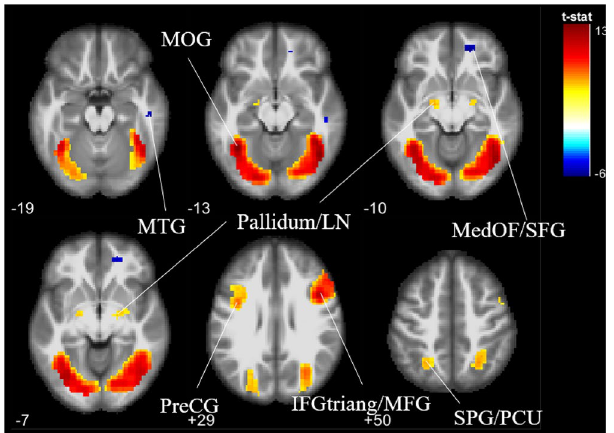
Figure 2. Similarities in brain activations and deactivations to non-own ethnic in-group versus non-own ethnic out-group infant faces (IG ∩ OG), p < 0.05 (FWE corrected). MOG middle occipital gyrus, MTG middle temporal gyrus, LN lentiform nucleus, MedOF medial orbitofrontal gyrus, SFG superior frontal gyrus, PreCG precentral gyrus, IFGtriang pars triangularis of the inferior frontal gyrus, MFG middle frontal gyrus, SPG superior parietal gyrus, PCU